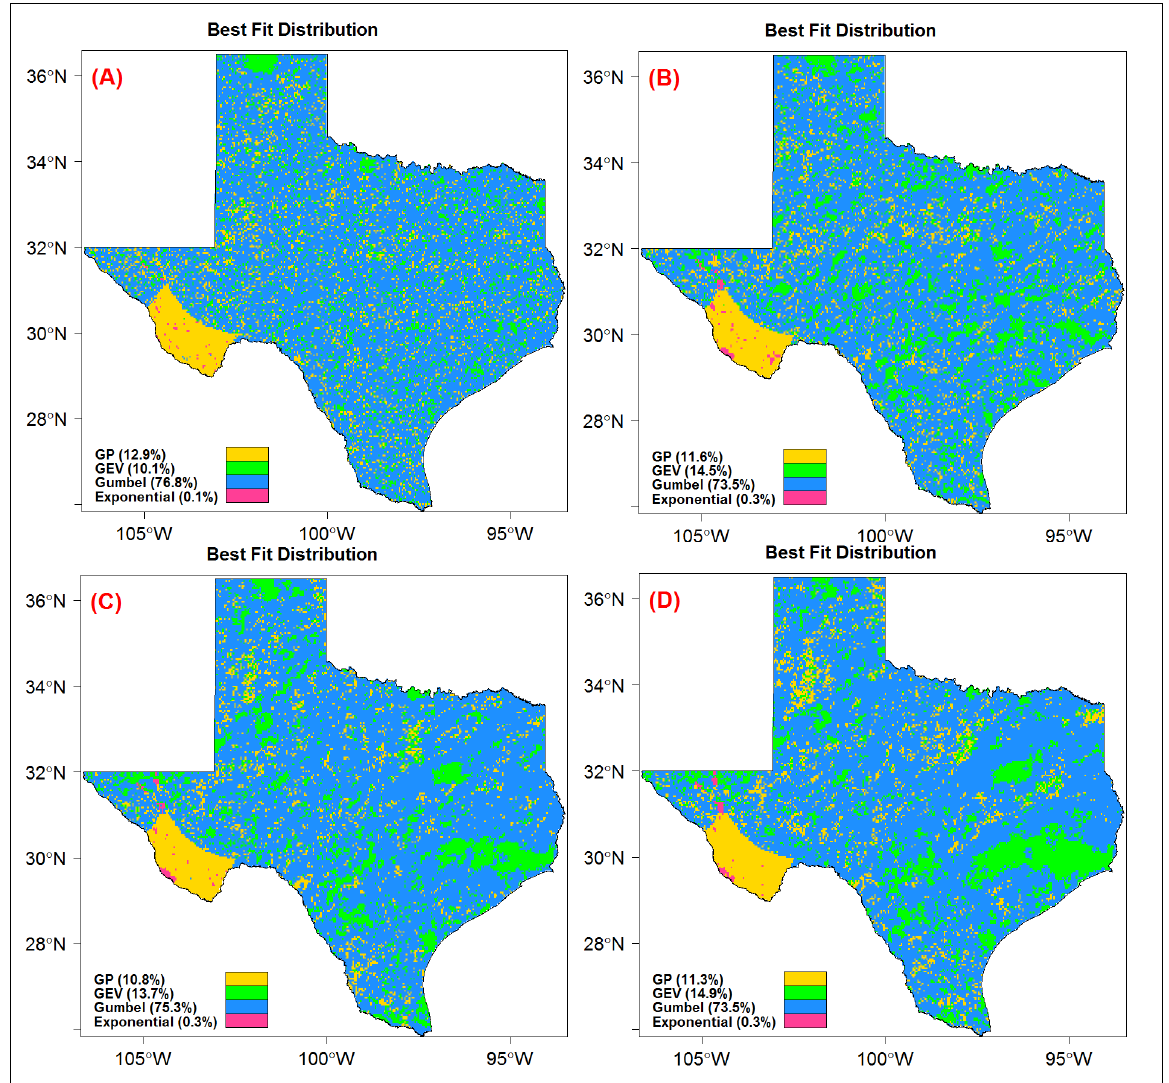
Figure 6. Spatial distribution of the best statistical model to fit the AMS for the ( A ) 1-h, ( B ) 6-h, ( C ) 24-h, and ( D ) 48-h storm durations.